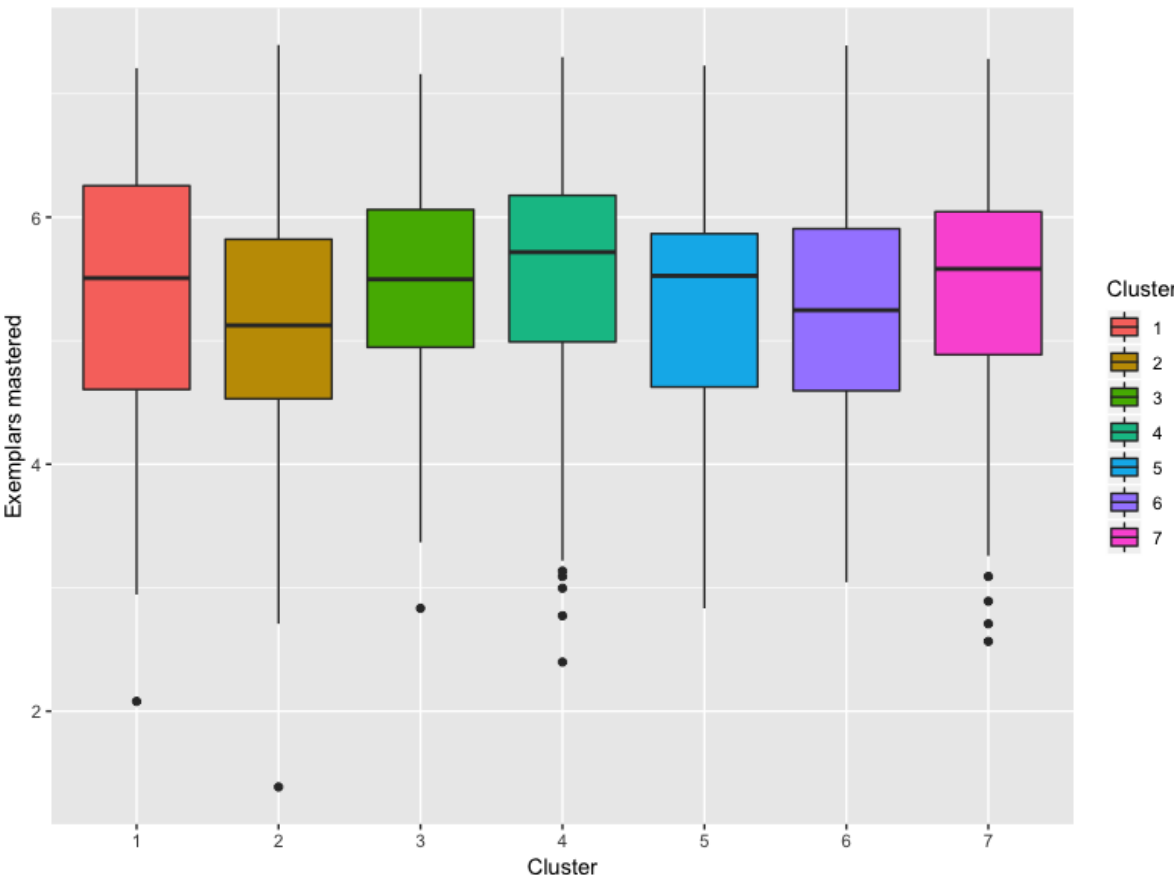
Figure 5. Box plots for each cluster. The box plots show the range of the exemplars mastered for each cluster, where the whiskers represent the minimum and maximum values. The line across each box is the median. The top of the box represents the third quartile. The bottom of the box represents the first quartile. Any points on the graph represent outliers in the clusters.